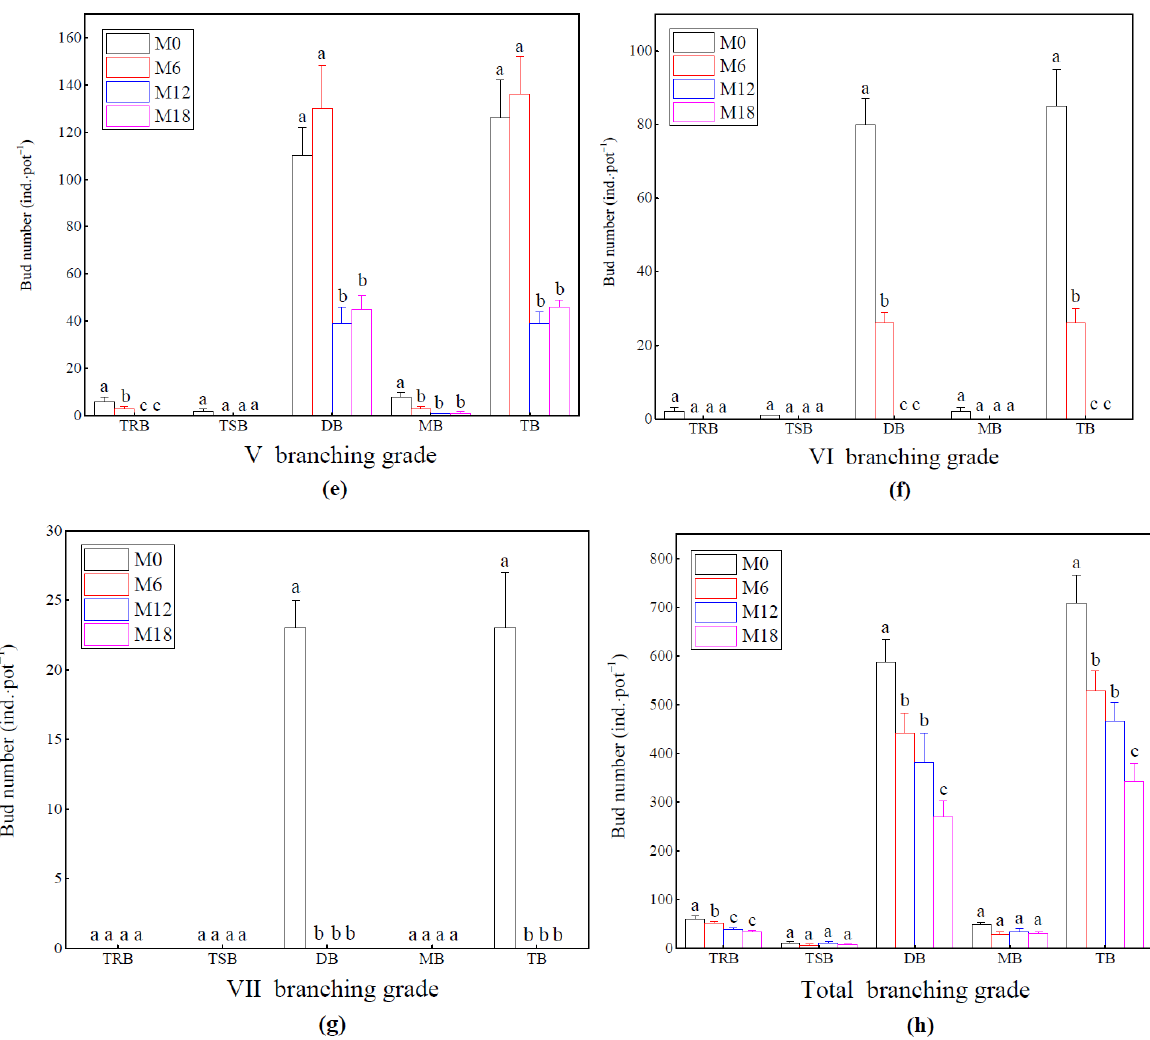
Figure 6. Quantitative characteristics of rhizome bud bank. ( a ) I branching grade; ( b ) II branching